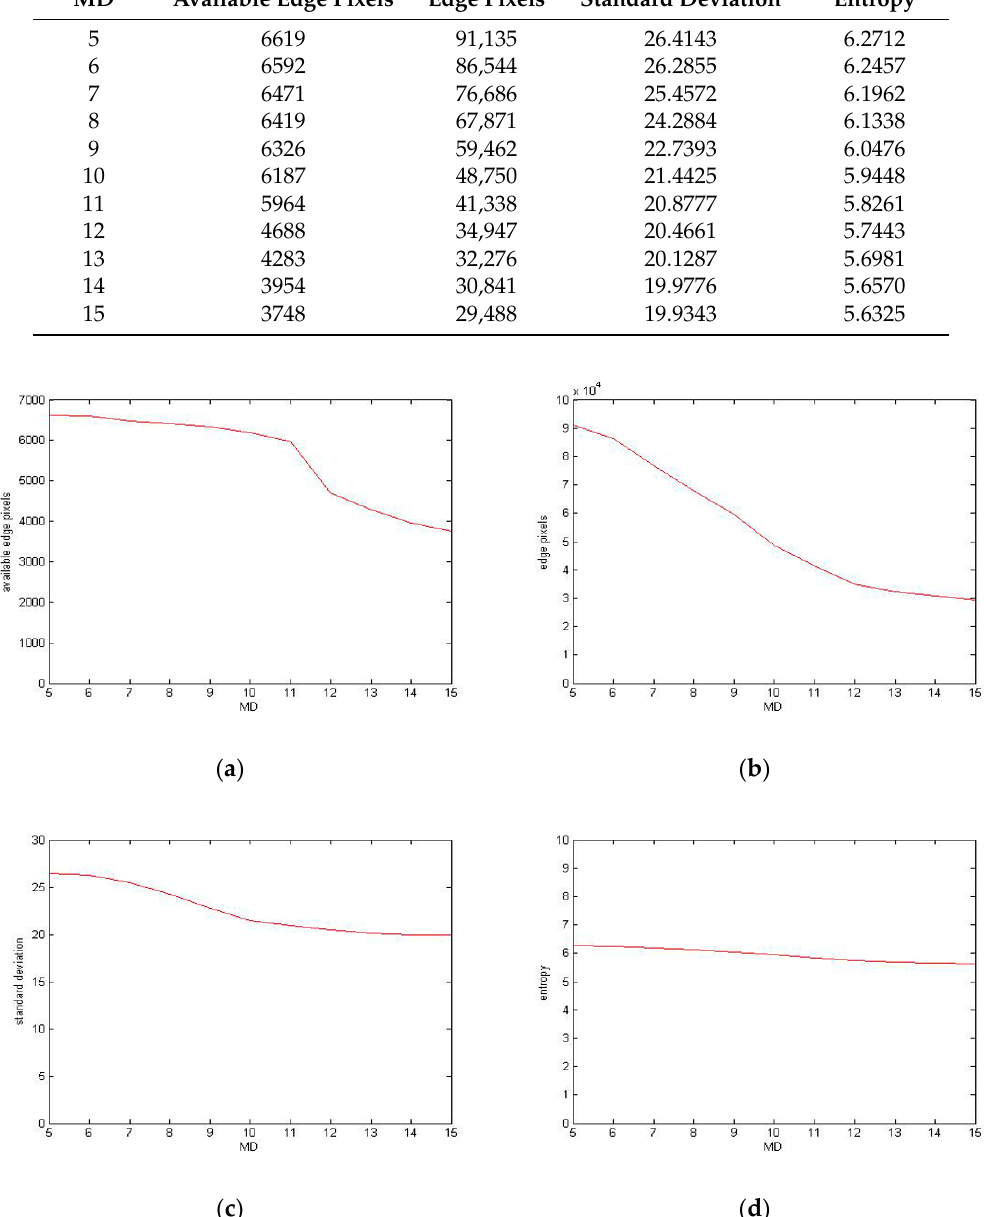
Figure 12. ( a ) The number of available edge pixels corresponding to the values of different parameter MD. ( b ) The number of edge pixels corresponding to the values of different parameter MD. ( c ) The values of standard deviation corresponding to the values of different parameter MD. ( d ) The values of entropy corresponding to the values of different parameter MD.